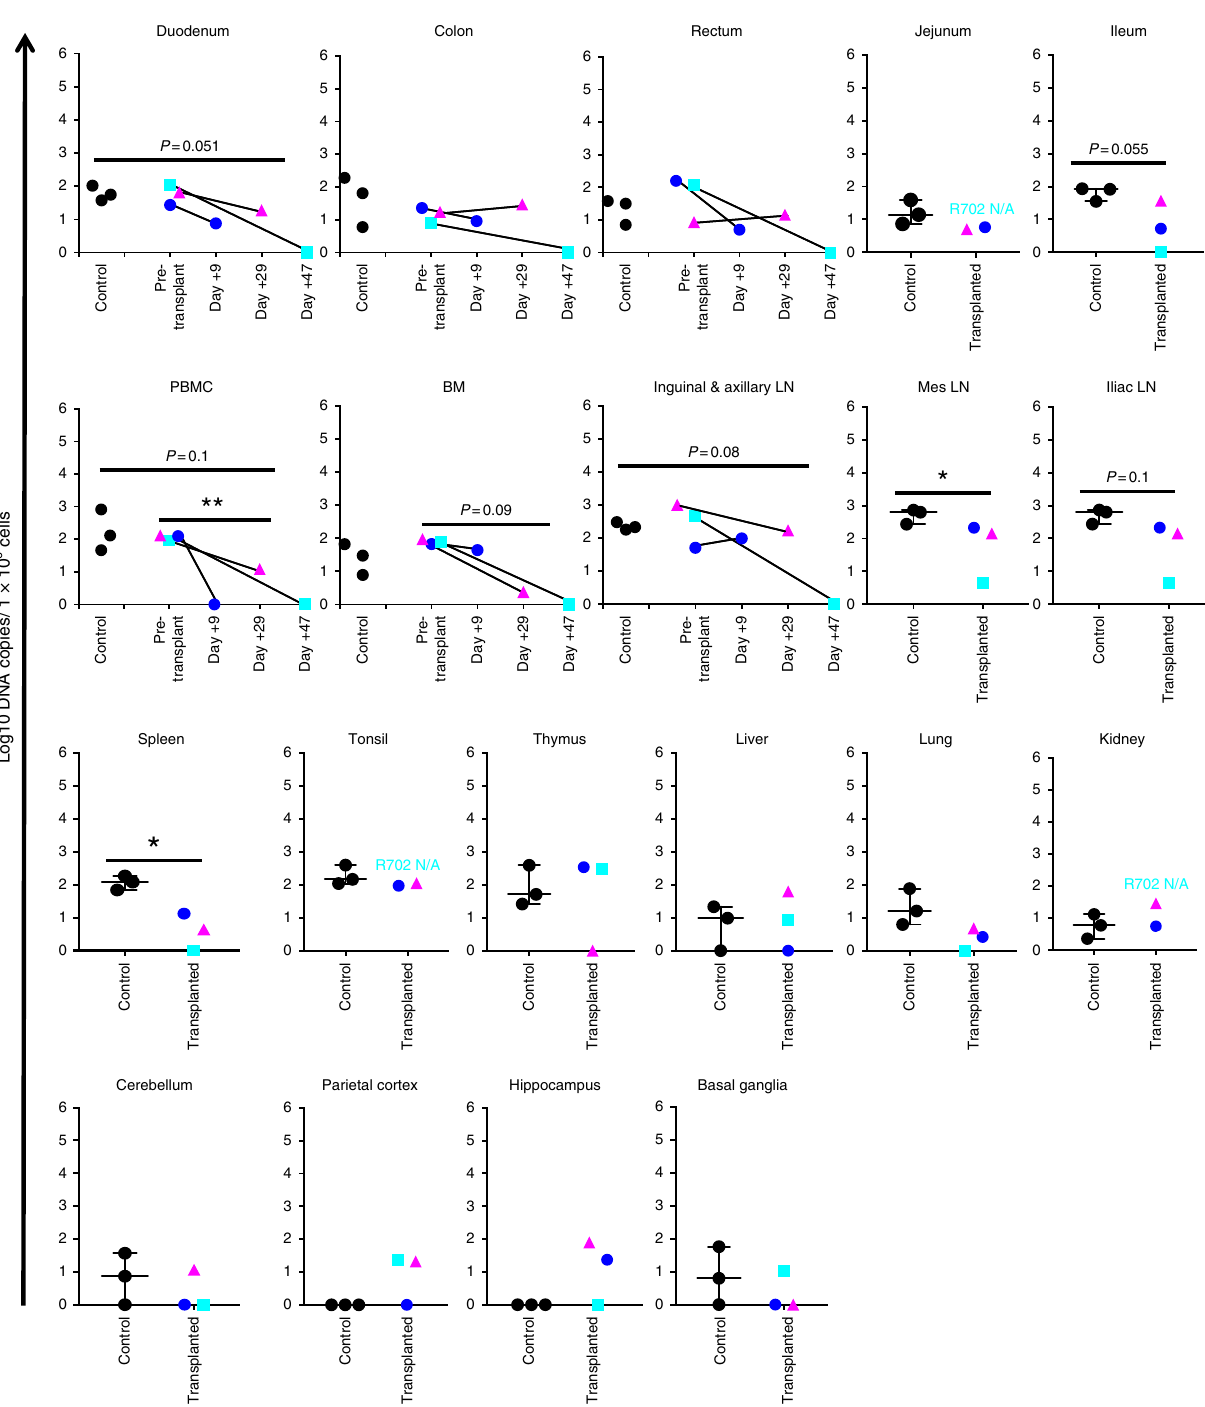
Fig. 6 SHIV-C DNA in transplanted recipients and controls. Genomic DNA (gDNA) was extracted from the tissues listed in Fig. 5. Total SHIV DNA was measured by qPCR with GAG-speci fi c primers, and normalized to SHIV DNA copy number per 1 × 10 6 cells with the aid of a genomic DNA standard (macaque RNaseP p30, MRPP30) 35 . Where applicable, measurements at multiple time points in transplanted animals are indicated. Error bars represent the mean with SEM. * p ≤ 0.05; ** p ≤ 0.01. Pre-transplant vs. necropsy PBMC: p = 0.009, t = 10.68, df = 2, paired two-tailed t test; mesenteric LN: p = 0.049, t = 2.796, df = 4, unpaired two-tailed t test; spleen: p = 0.024, t = 3.538, df = 4, unpaired two-tailed t